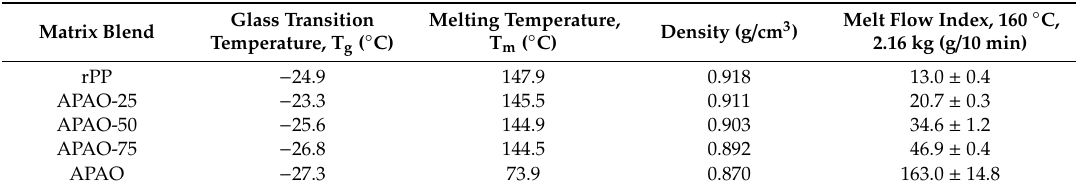
Table 1. Thermal properties and MFI values of the matrix blends.